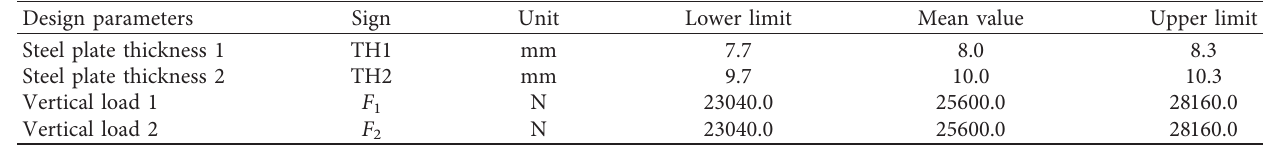
Table 2: Statistical characteristic of random variables.